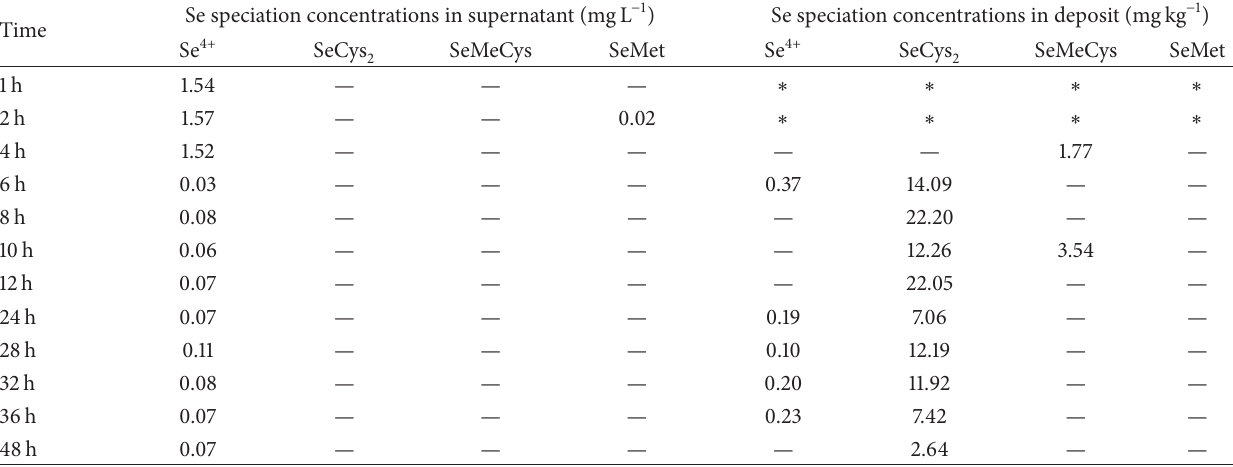
Table 4: Concentrations of Se speciations (Se 4+ , SeCys 08+6, was grown in the culture medium with 1.5 mgSeL − 1 ).